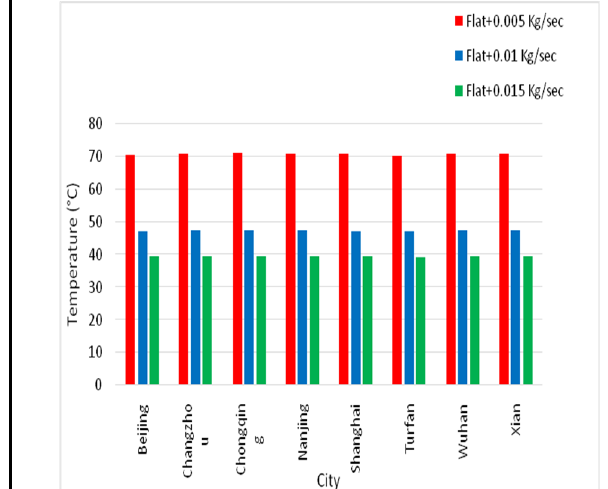
Fig. 2: Temperatures of operational fluid used for SFPC with eight china cities and varying